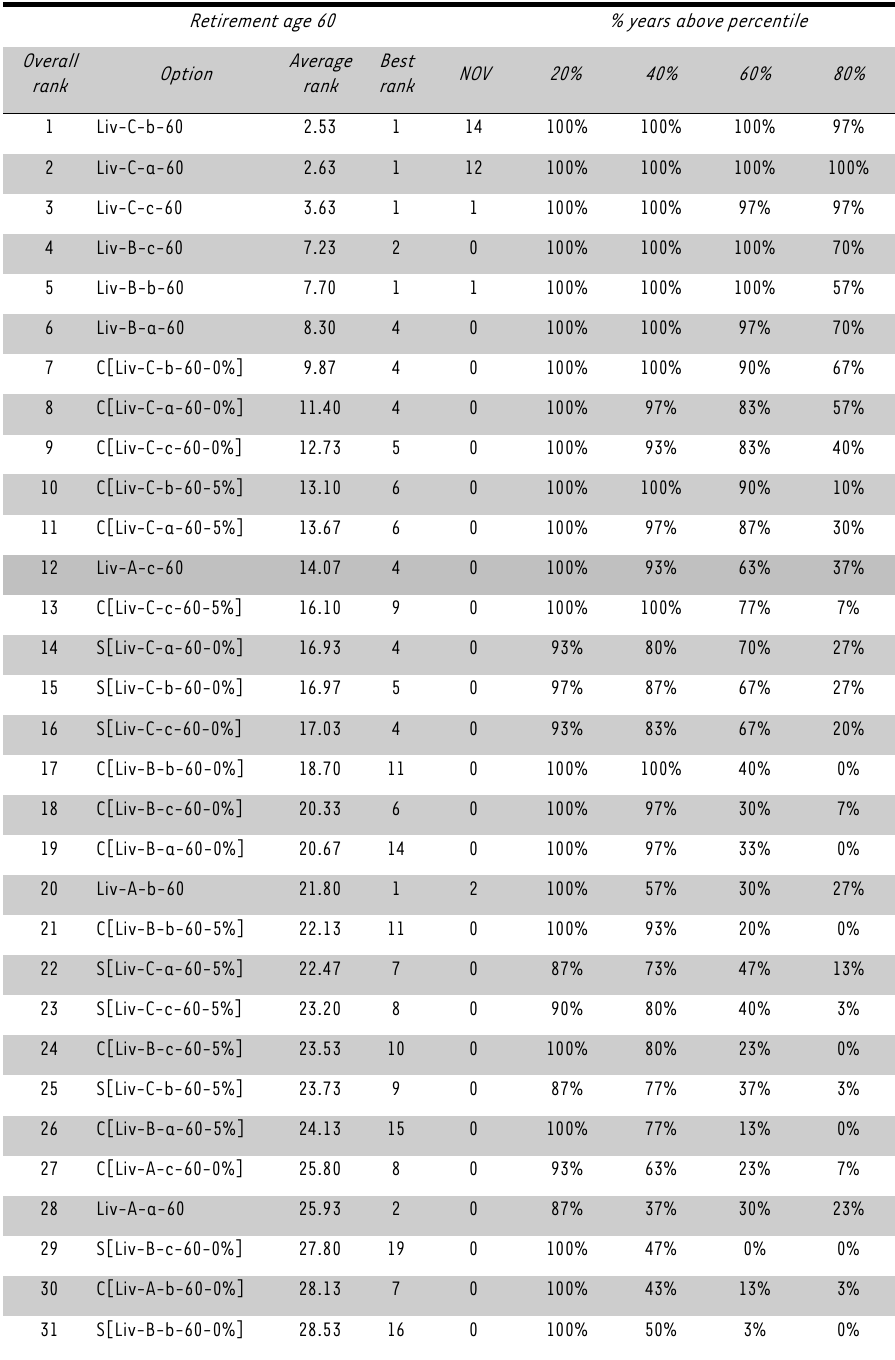
TABLE 3: All annuity strategies ranked by average rank for a male retiree aged